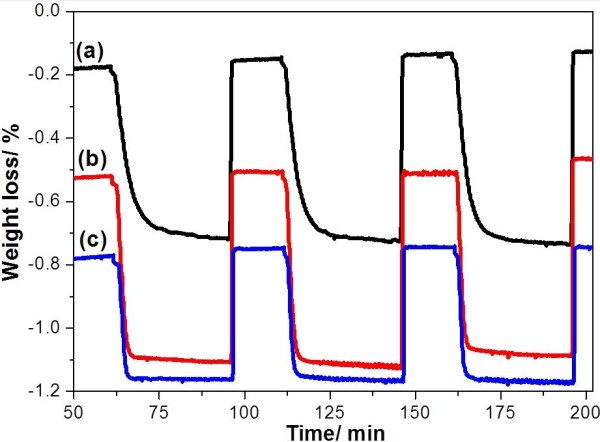
TG profiles during measurement ofOSC at 600°C for calcined samples(1,000°C, 20 h). The profiles show oxygen release/storage properties. (a) Ce0.5Zr0.4Al0.1O1.95, (b) Ce0.5Zr0.2Al0.3O1.85, and (c) Ce0.5Zr0.1Al0.4O1.8.